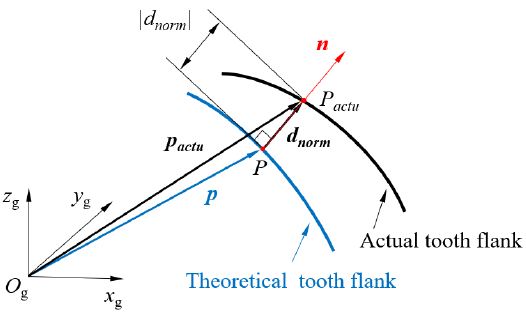
Figure 2. Normal deviations of the tooth surface.